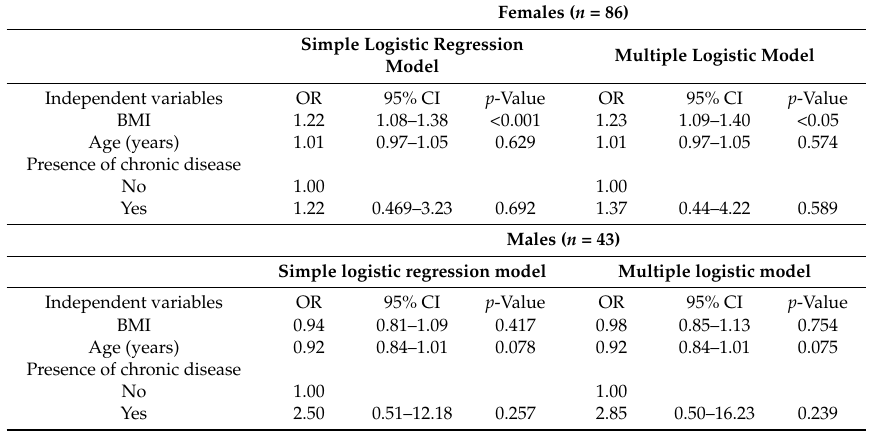
Table 3. Odds ratio (OR) and 95% CIs for scoring above 75th percentile ORWELL 97 and among patients with obesity seeking